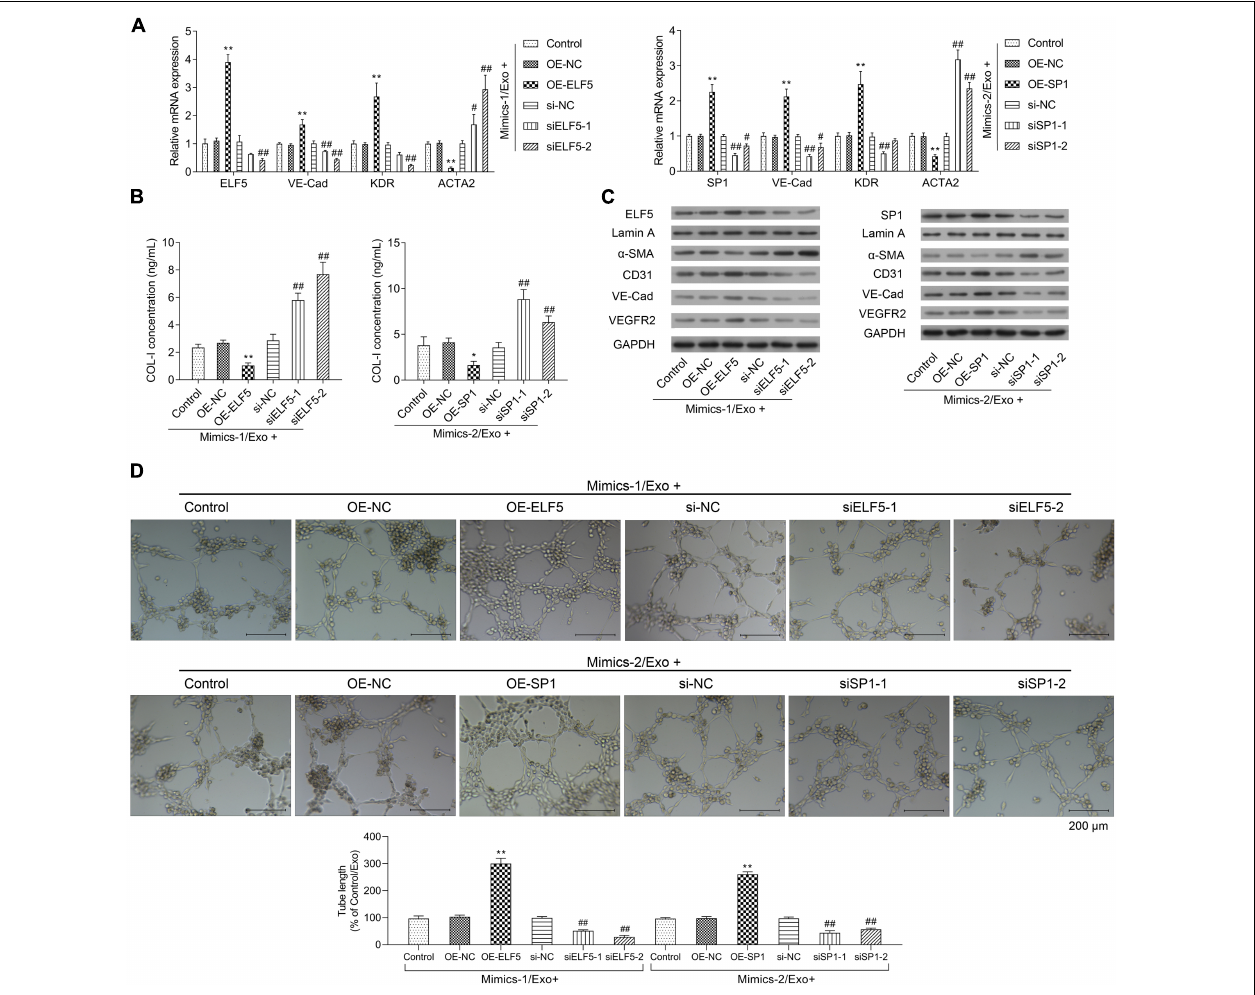
FIGURE 5 | Role of ELF5 and SP1 in angiogenesis induced by exosomes from EPCs. In parent HCFs or those transfected with empty plasmids (OE-NC), SP1 overexpression plasmids (OE-SP1), ELF5 overexpression plasmids (OE-ELF5), siRNA-1 against SP1 (siSP1-1), siRNA-2 against SP1 (siSP1-2), siRNA-1 against ELF5 (siELF5-1), siRNA-2 against ELF5 (siELF5-2), or the negative control (si-NC), the expressions of ELF5, SP1, VE-Cad, VEGFR2, and ACTA2 were determined by qRT-PCR (A) , the level of COL-I in medium was examined by ELISA (B) , and the proteins levels of ELF5, SP1, Lamin A, α -SMA, CD31, VE-Cad, and VEGFR2 were determined by western blot (C) . Additionally, the angiogenesis of the cells were determined by tube formation assay (D) . N = 3. * P < 0.05, ** P < 0.01 vs. OE-NC group; # P < 0.05, ## P < 0.01 vs. si-NC group. Exo, exosomes; Mimics-1, miR-1246 mimics; Mimics-2, miR-1290 mimics.